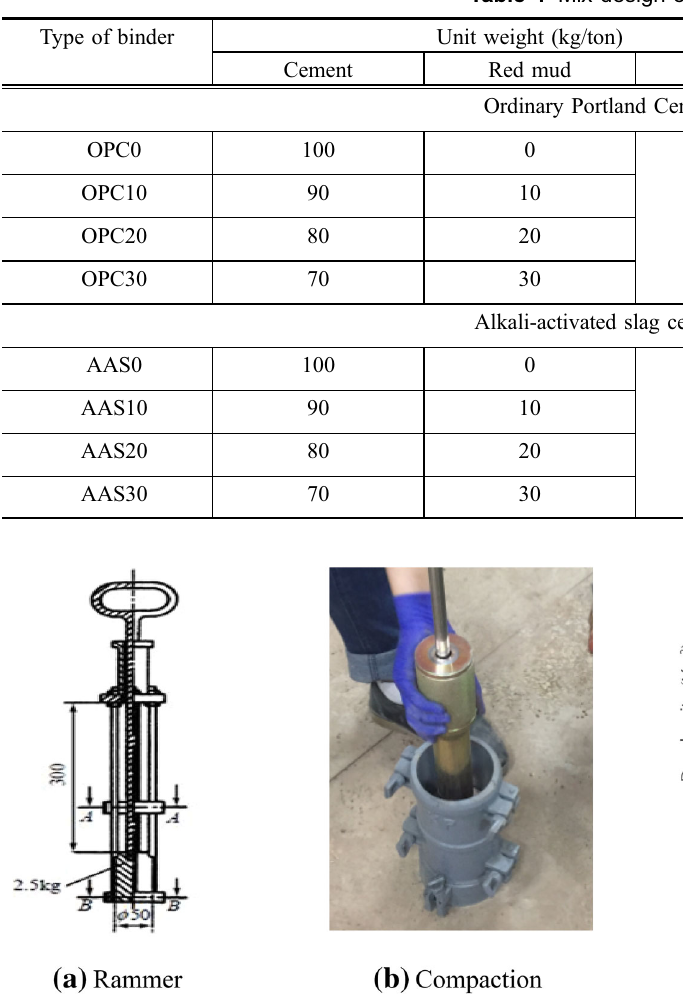
Fig. 4 Compaction rammer.